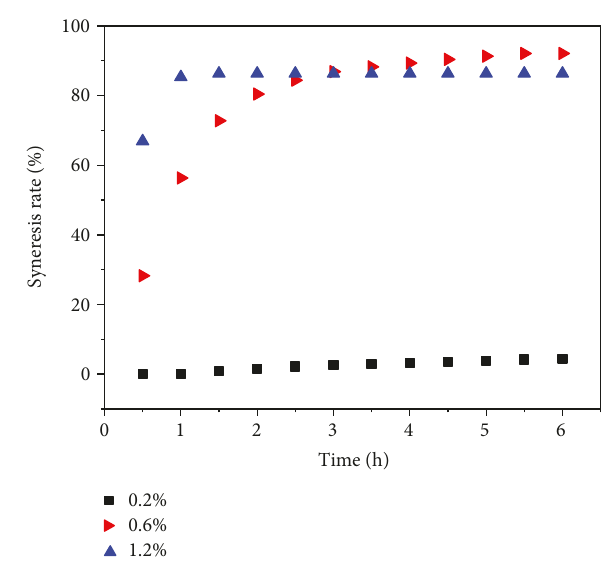
Figure 6: The syneresis rate of emulsion under di ff erent content of